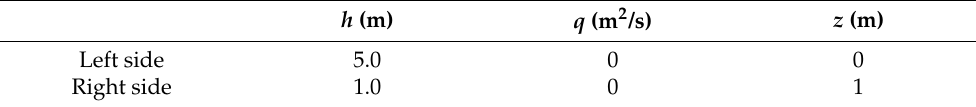
Table 6. Initial conditions for a rarefaction and a hydraulic bore propagating over a step.